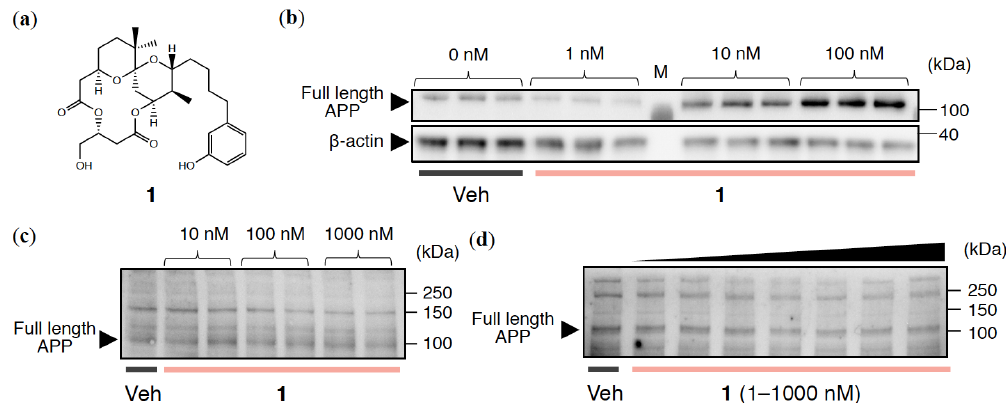
Figure 1. ( a ) Structure of 10-Me-Aplog-1 ( 1 ). APP expression levels in ( b ) HEK293-APPwt, ( c ) SH-SY5Y, and ( d ) rat primary cerebral cortex cells treated with 1 at the indicated concentrations for 24 h. M indicates marker. In ( d ), 1, 10, 50, 100, 500, and 1000 nM (from left to right) of 1 were used. Veh: vehicle.